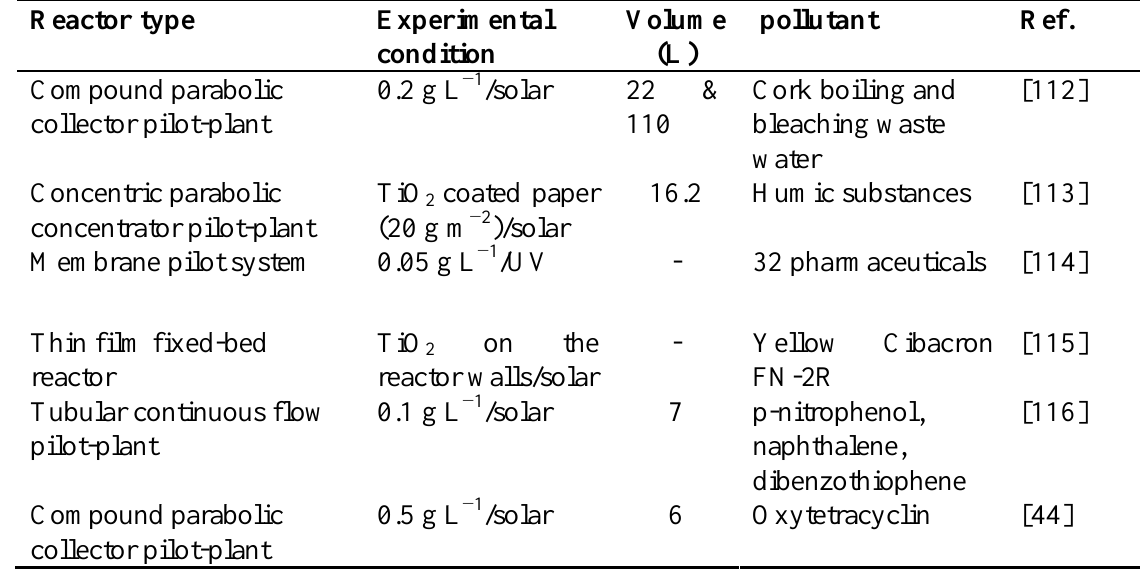
Table 2. Examples of large-scale photocatalytic